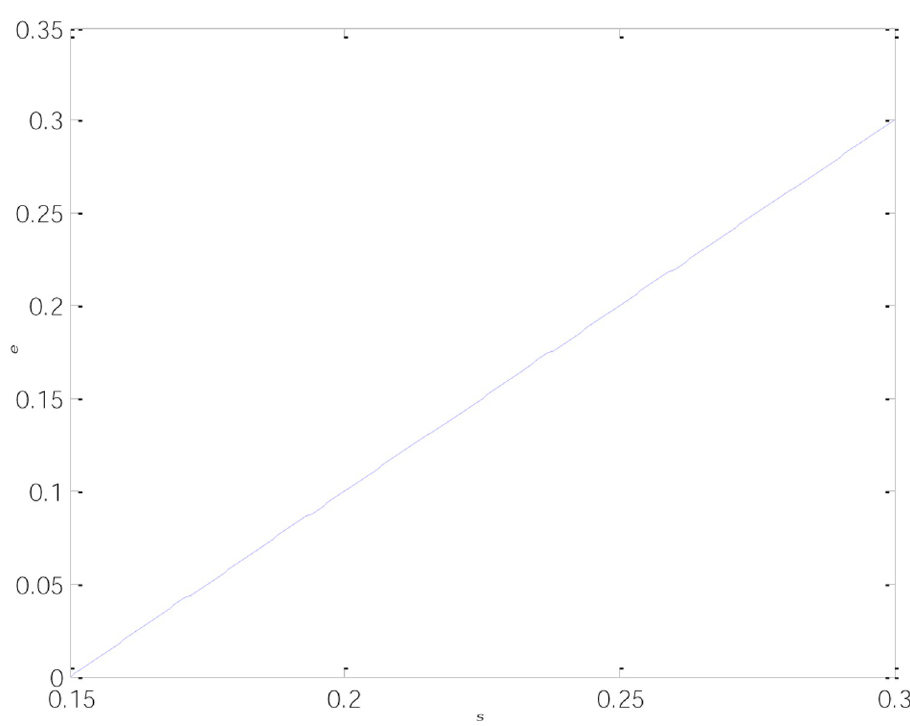
Fig 2. Relationship between the optimal emissions reductions and low-carbon